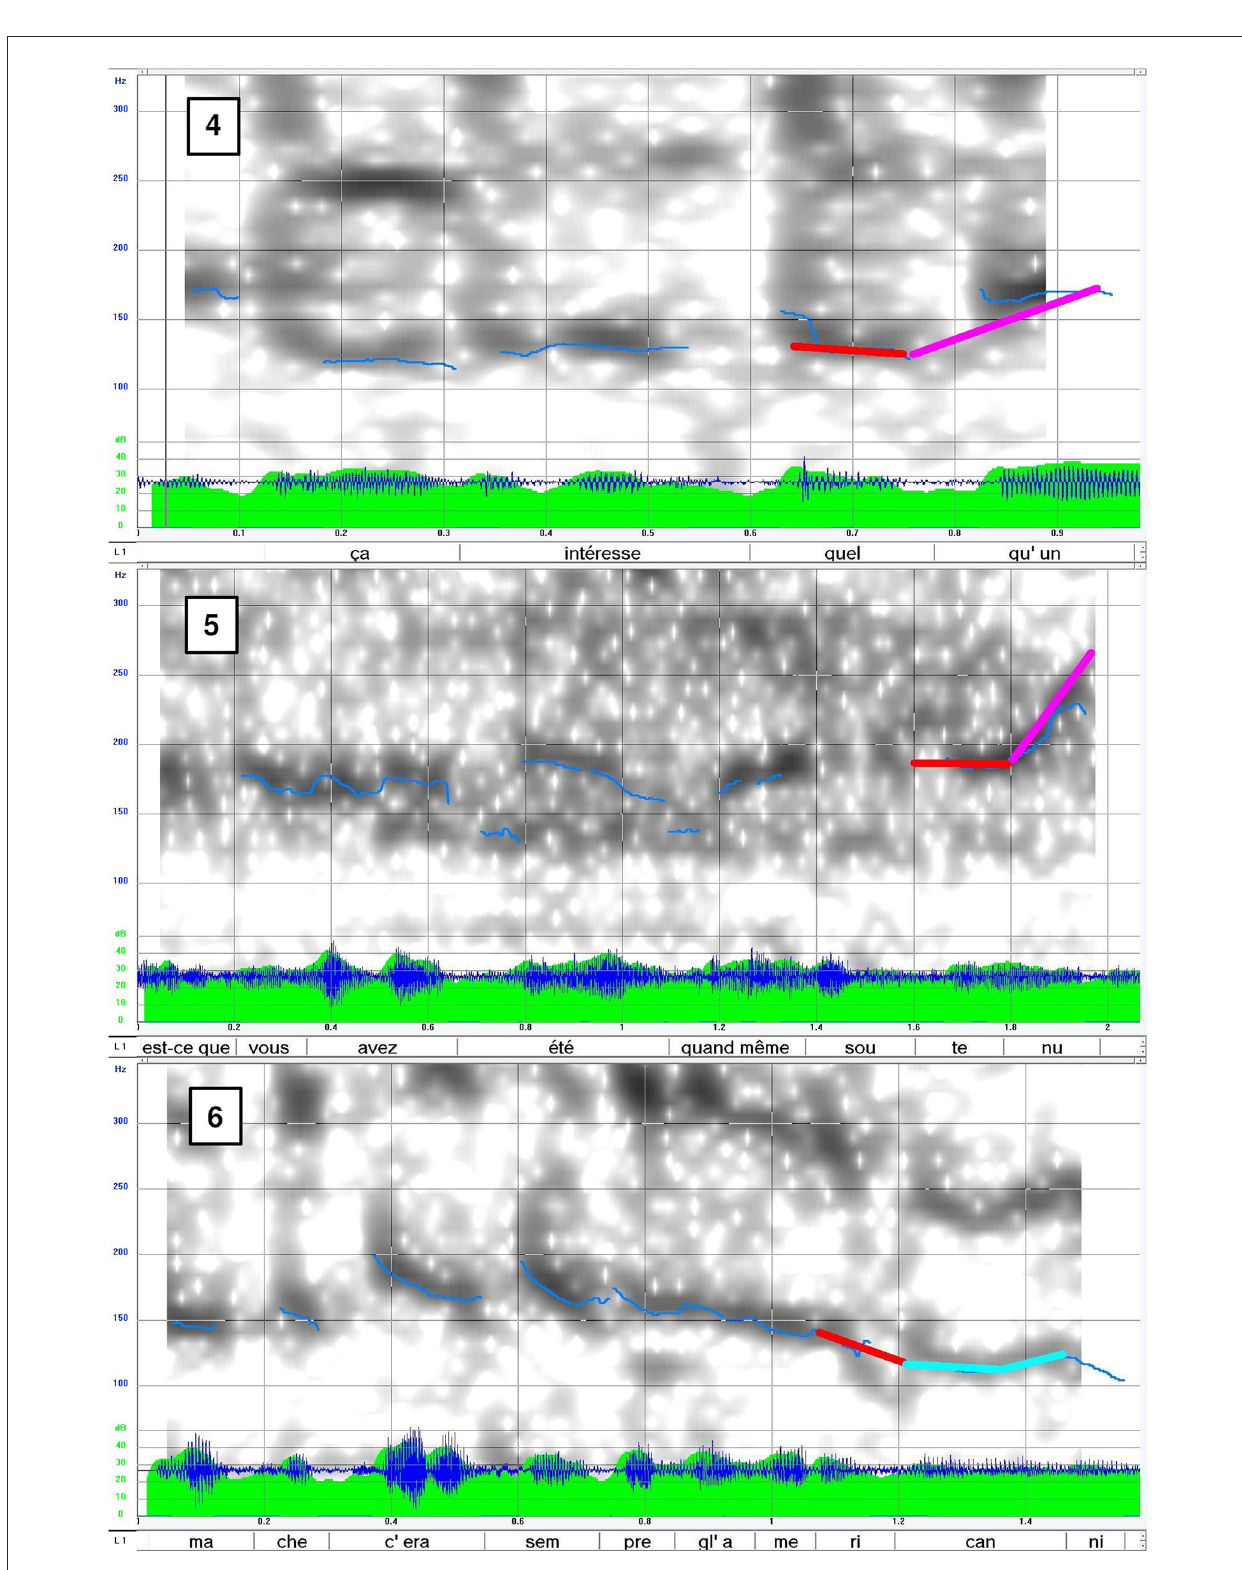
FIGURE5 Prosodic variants of Requests for confirmations in French and Italian (4–6) (Supplementary Audio